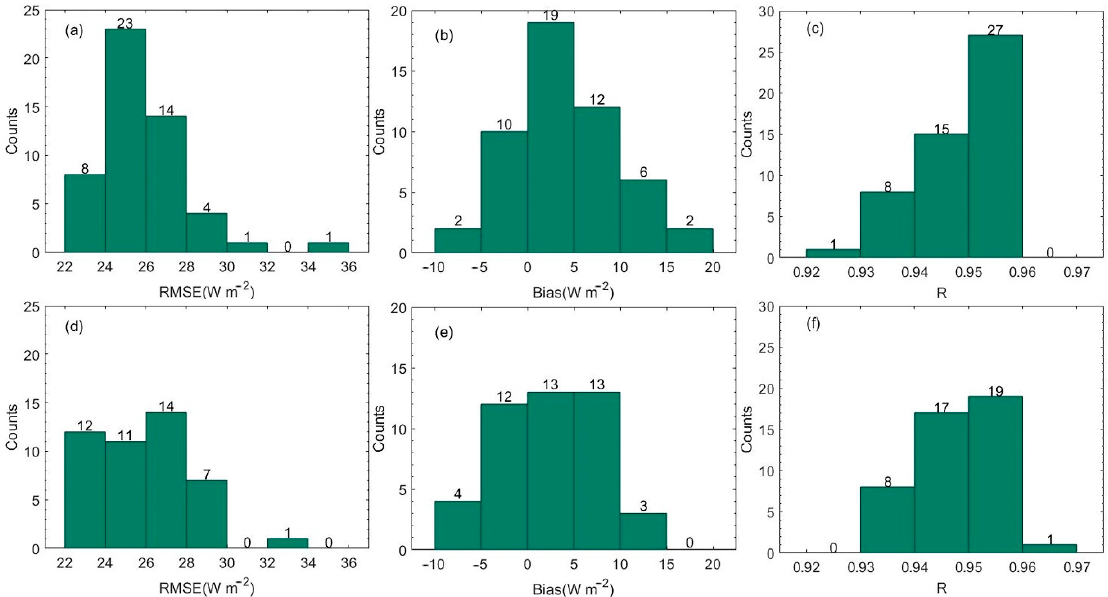
Figure 5. RMSE, bias, and R histograms for monthly SULR simulations from the 51 CMIP6 GCMs ( a – c ) and the 45 CMIP5 GCMs ( d – f ).